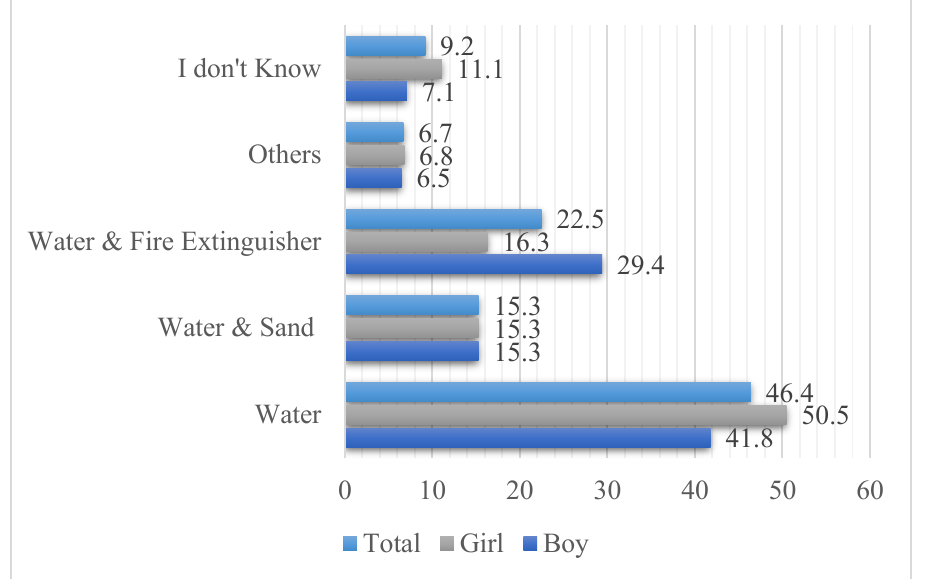
Source: own calculation, 2022